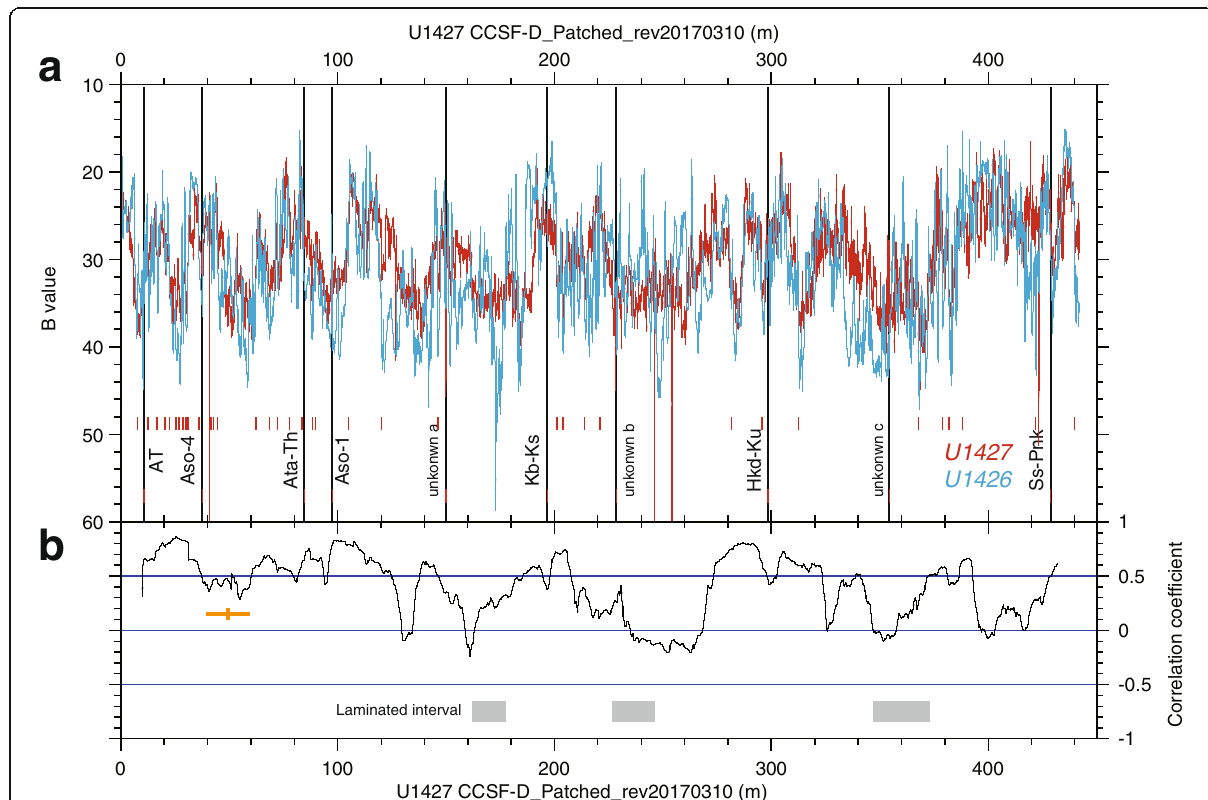
Fig. 9 a Comparison of sediment color profiles at Sites U1427 (red) and U1426 (blue) plotted on the U1427 depth scale. Note that the axis of B values is inverted. Control points by correlative tephra layers are shown by vertical black lines. Additional control points from color change correlation are shown by red lines. For additional details, see Additional file 8: Figure S2. b Moving correlation coefficient of two color profiles, calculated for a 20 m window with width indicated by orange bar. Intervals of laminated sediment at Site U1427 are shown at the base of the lower